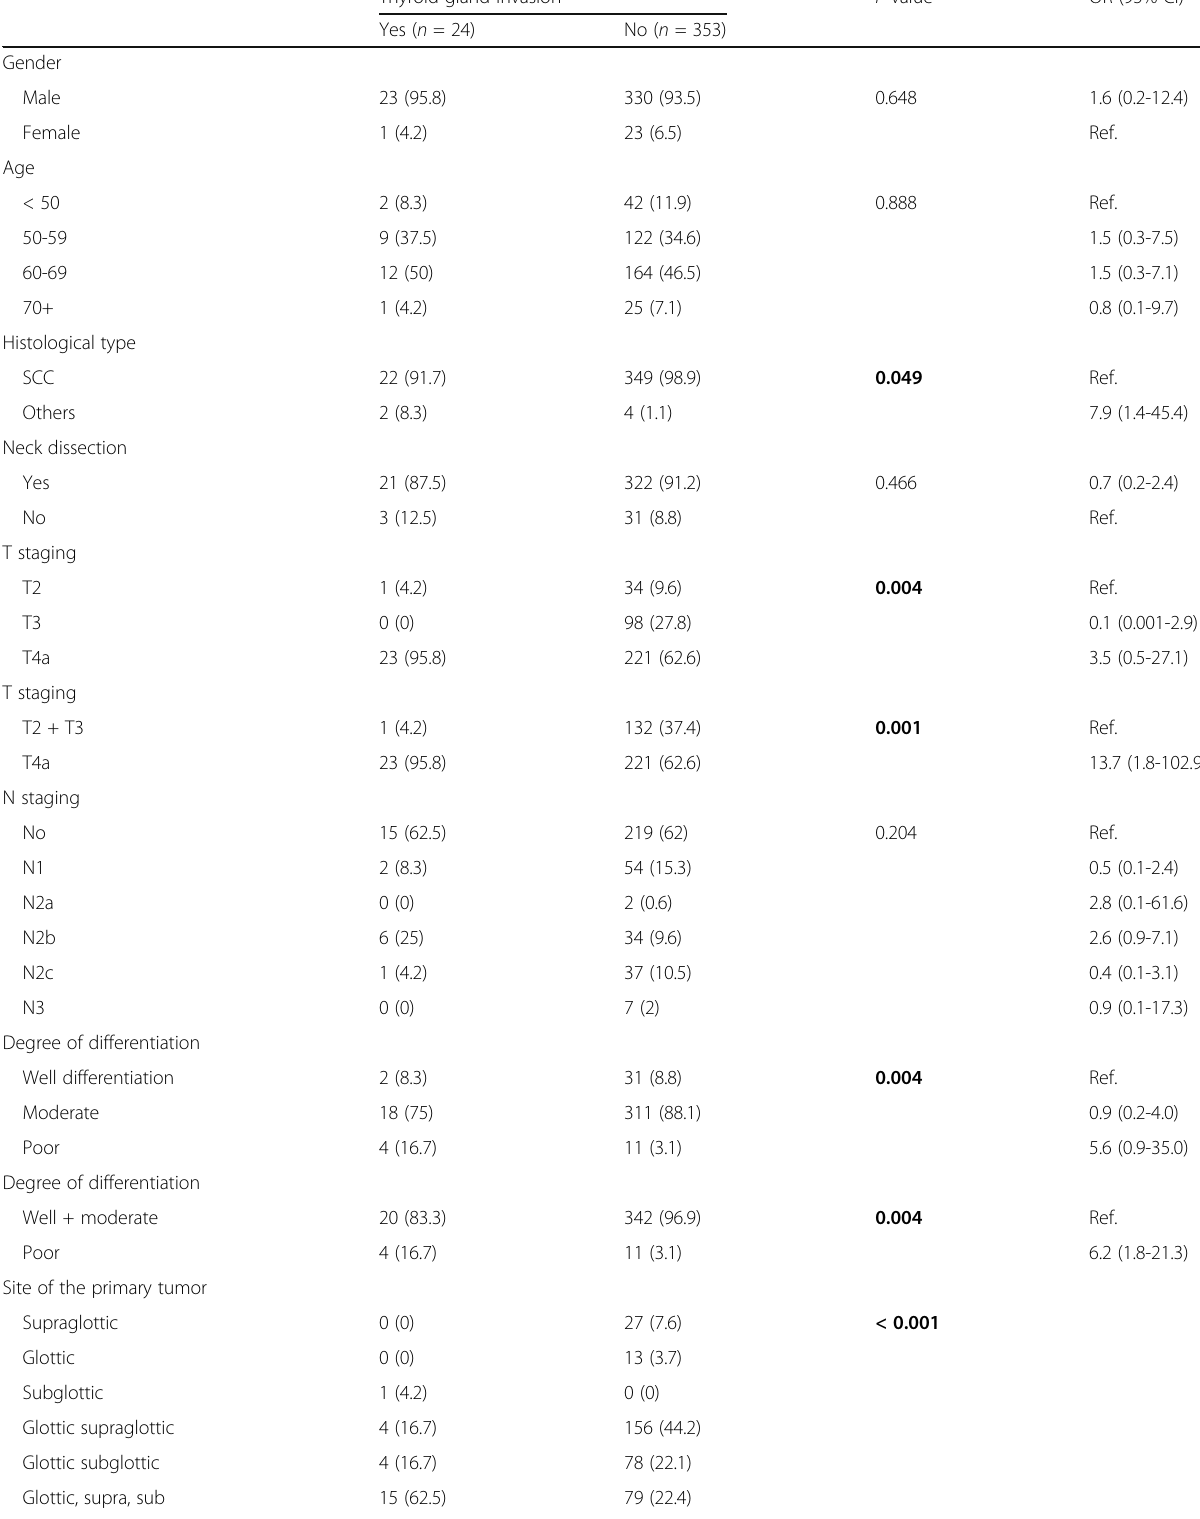
Table 2 Analysis of the correlation of all variables and the incidence of thyroid gland invasion by the